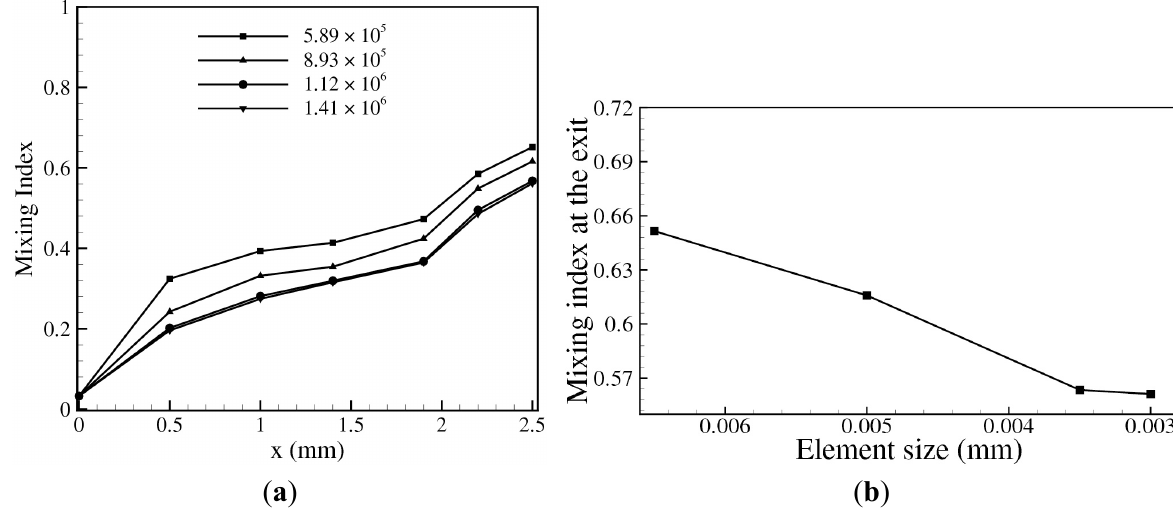
Figure 2. Grid-dependency test at Re = 45: ( a ) number of nodes and ( b ) mesh element